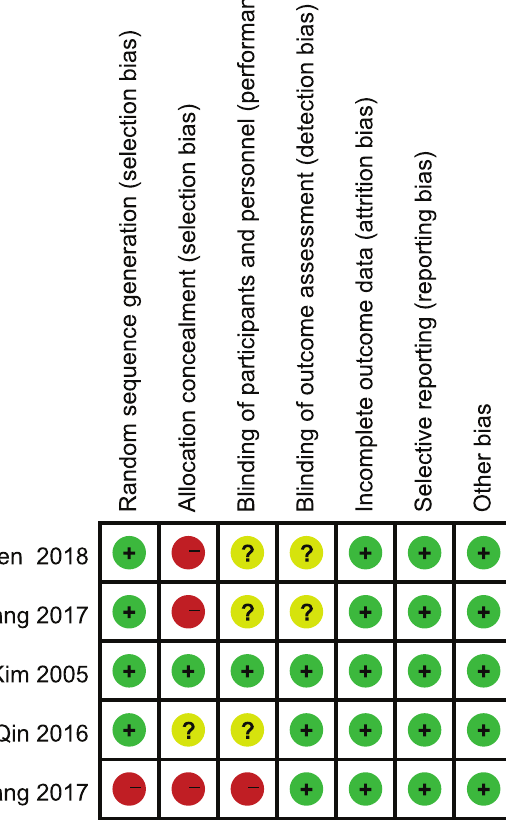
Figure 3. Risk of bias summary: reviewers’ judgments about each risk of bias item for each included study.